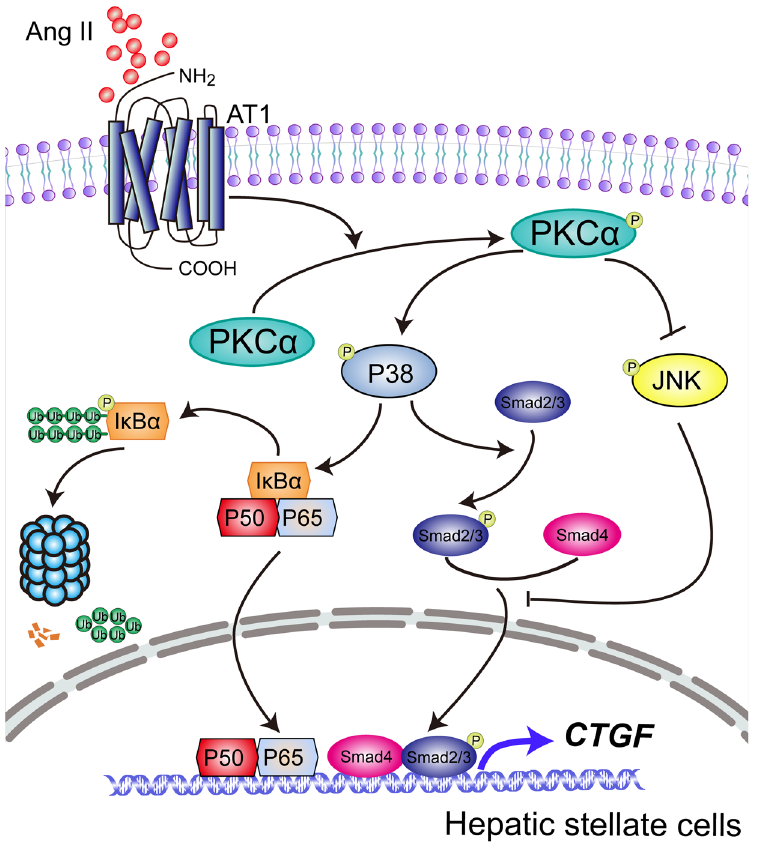
Figure 10. Schematic diagram of possible molecular mechanisms underlying the transcriptional regulation of CTGF expression in Ang II-stimulated